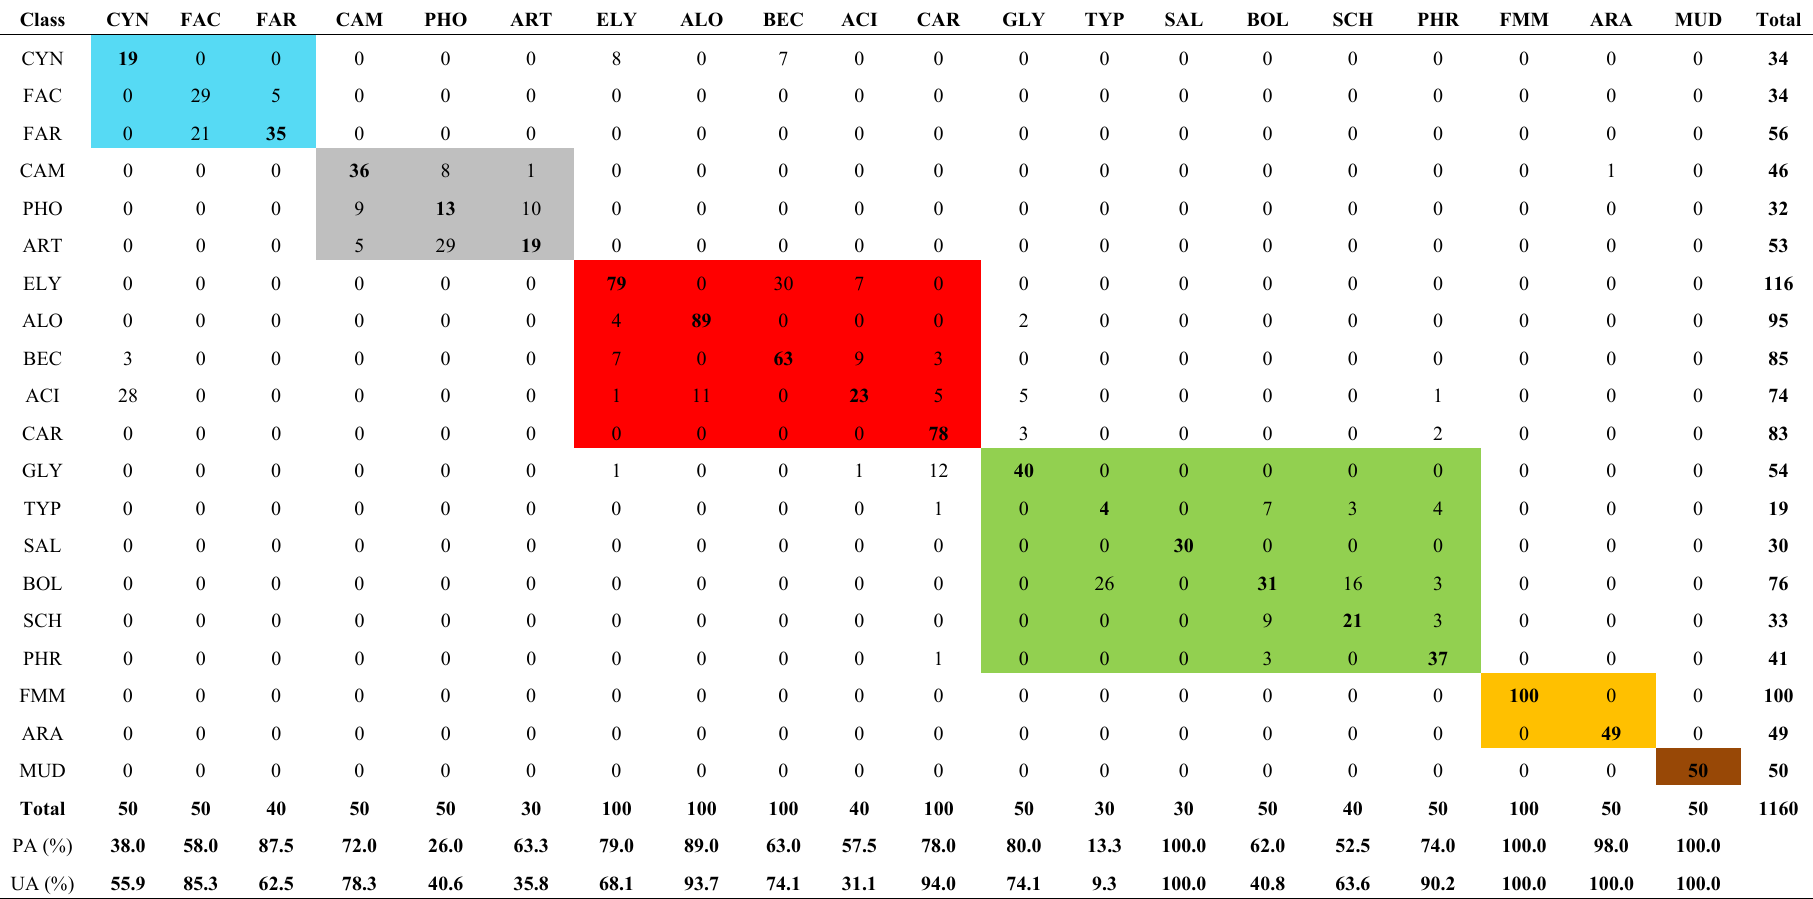
Table 3. Confusion matrix of SVM classification using original bands with 30 training pixels. Identical groups are represented by the same color (cyan—dry steppic grasslands; gray—open alkali grasslands; red—meadow and sedge vegetation; green—marshes; orange—sparsely vegetated areas; brown—muddy surface). Notations: UA: User’s Accuracy; PA: Producer’s